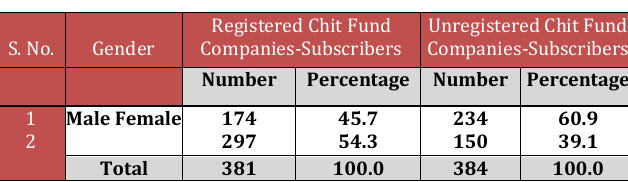
Table 1: Gender classification of the registered and unregistered chit funds